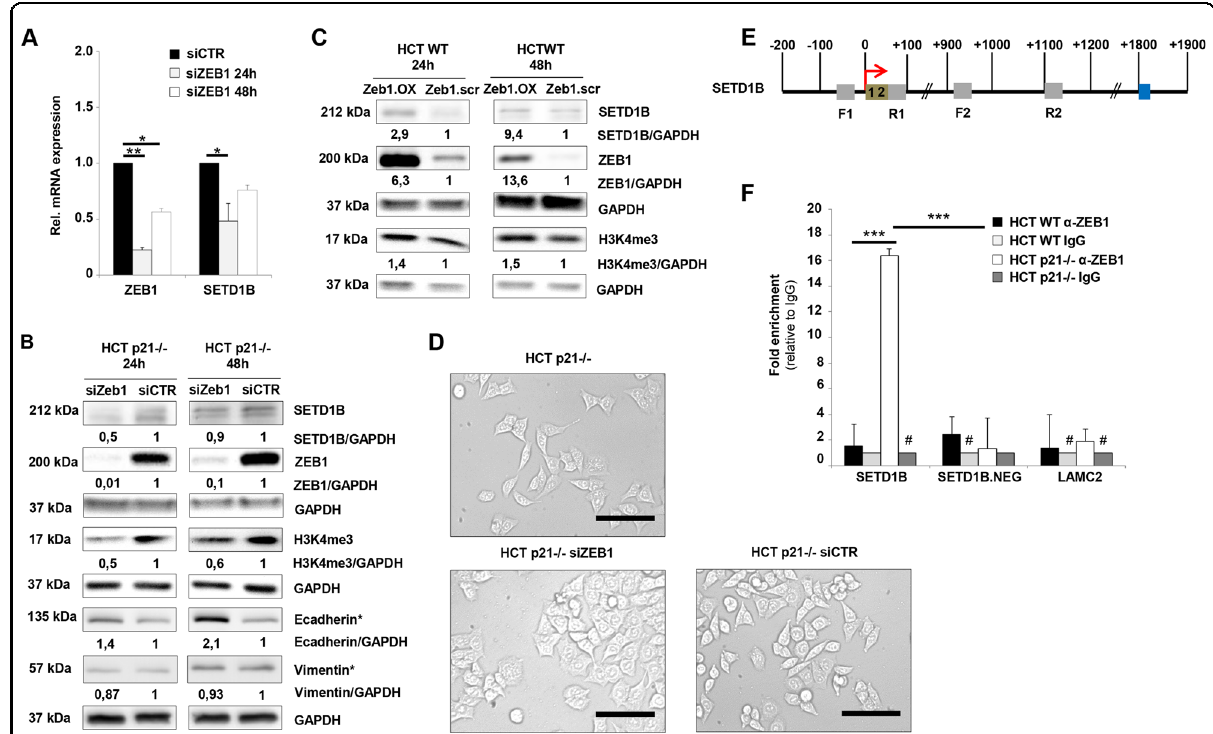
Fig. 2 ZEB1 affects the expression of chromatin modi fi cation enzymes. a , b RT-qPCR analysis of SETD1B and representative western blot analysis of E-Cadherin, Vimentin, SETD1B, and H3K4me3 in HCT p21 – / – cells upon ZEB1 knockdown after siRNA transfection; n = 3 (* p < 0.05; ** p < 0.01). Fold expression (western blot) is represented relative to GAPDH loading control; n = 3. *Samples were loaded on the same membrane c Representative western blot analysis of SETD1B and H3K4me3 in HCT WT cells upon ZEB1 overexpression after transfection; n = 3. Fold expression is represented relative to GAPDH loading control; n = 3. d Representative phase contrast images of HCT p21 – / – cells and of HCT p21 – / – cells upon ZEB1 knockdown after siRNA transfection for 24 h; Phase contrast magni fi cation = 200×; Scale bar = 100 μm; n ≥ 4. e Schematic display of promoter regions for SETD1B with respective ZEB1 E-Box binding sites (olive green), ZEB1 Z-Box binding site (blue), primer pairs (gray) and transcription start site (TSS) (red arrow). f ChIP analysis of ZEB1 binding capacity to SETD1B promoter region showing an increase of ZEB1 binding after loss of p21; n = 3 (*** p < 0.001). a , f Mean ± s.e.m. Unpaired two-tailed Student ’ s t